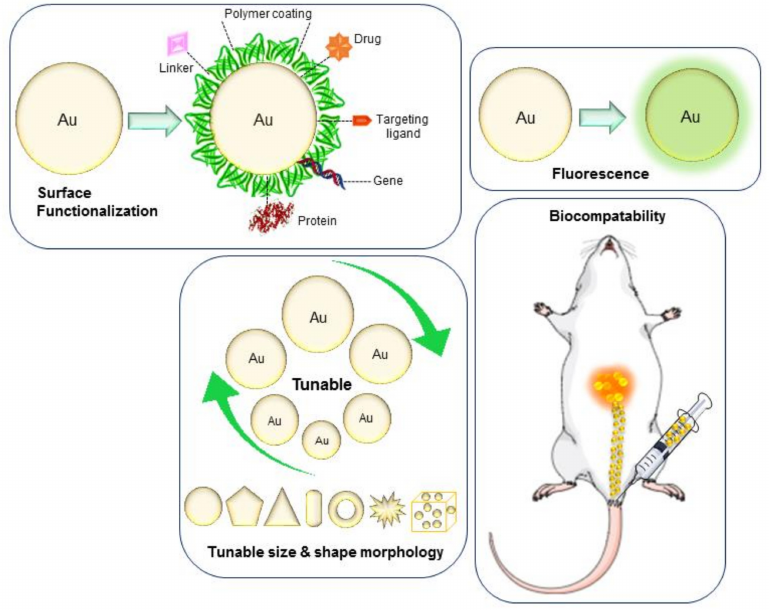
Figure 1. Important properties of gold